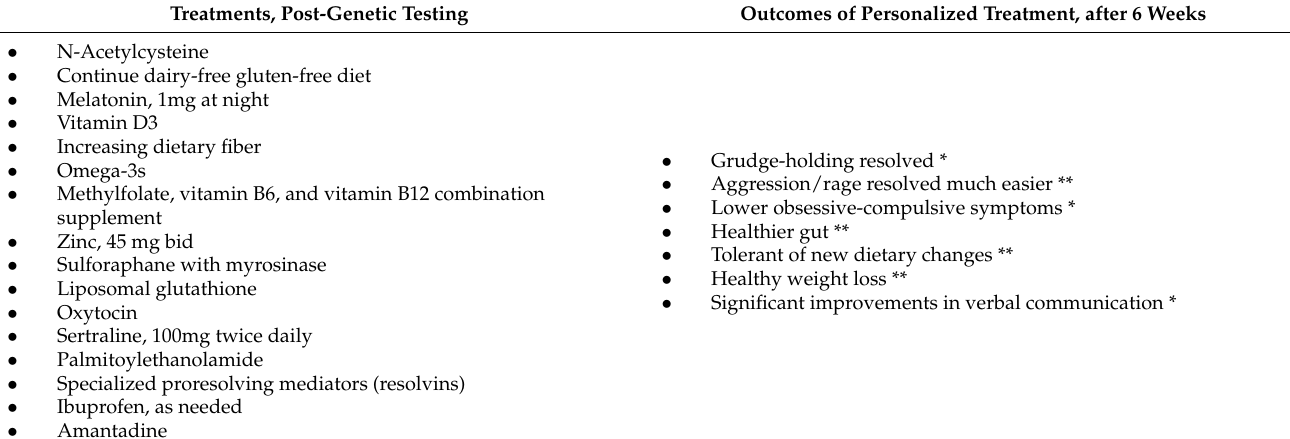
Table 2. Summary of the treatments prescribed after genomic testing and the improved outcomes after six weeks on these treatments. Bid = bi-daily; * = some improvement; ** = notable improvement. Treatments, Post-Genetic Testing Outcomes of Personalized Treatment, after 6